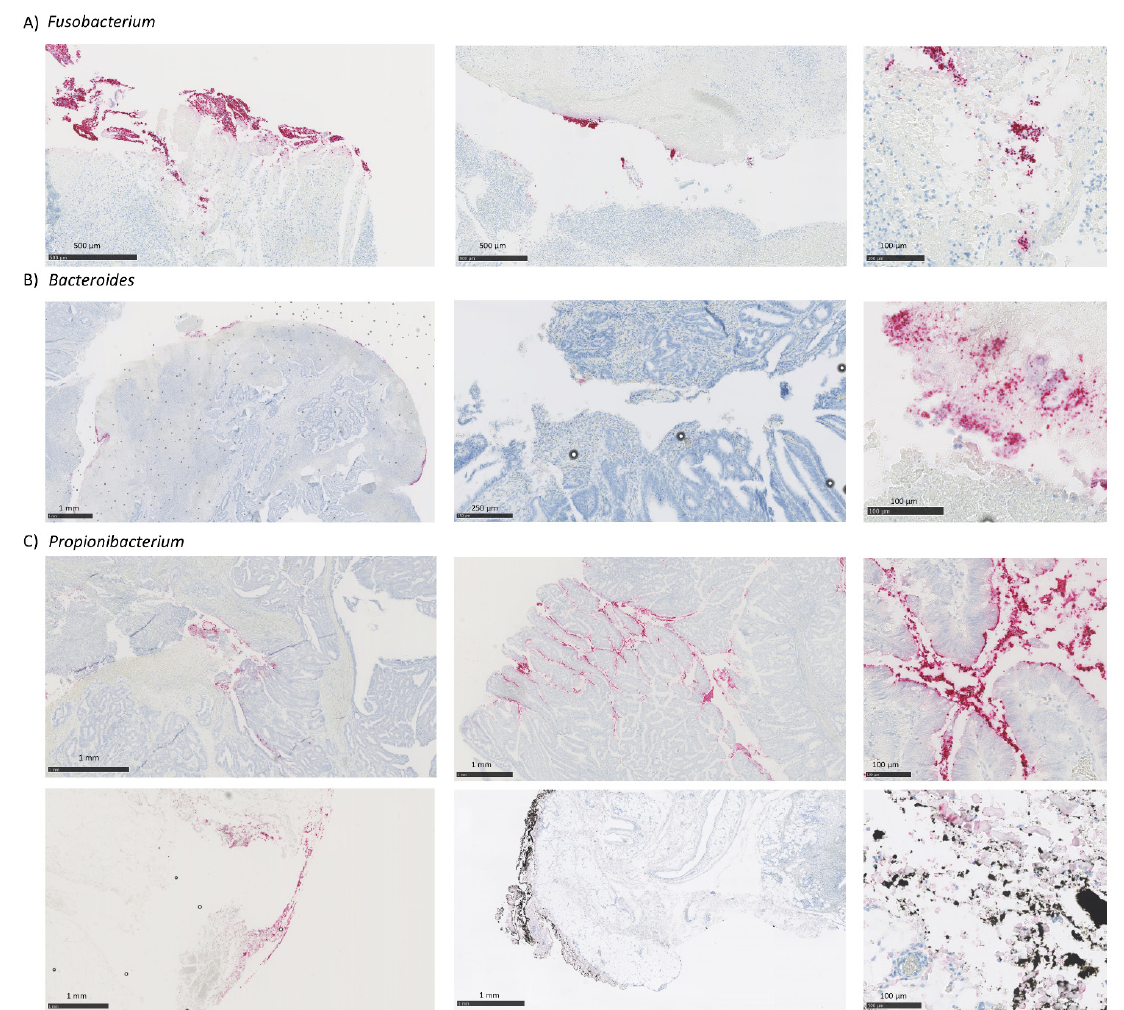
Figure 4. Representative RNA-ISH images in CRC tumor samples. ( A ) Representative images of Fusobacterium positive samples. ( B ) Representative images of Bacteroides positive samples. ( C ) Representative images of Propionibacterium positive samples showing the distinction between the tumor-associated Propionibacterium (top images) and the contaminant one (bottom images). Abbreviations: RNA-ISH; RNA in situ hybridization and CRC; colorectal cancer.